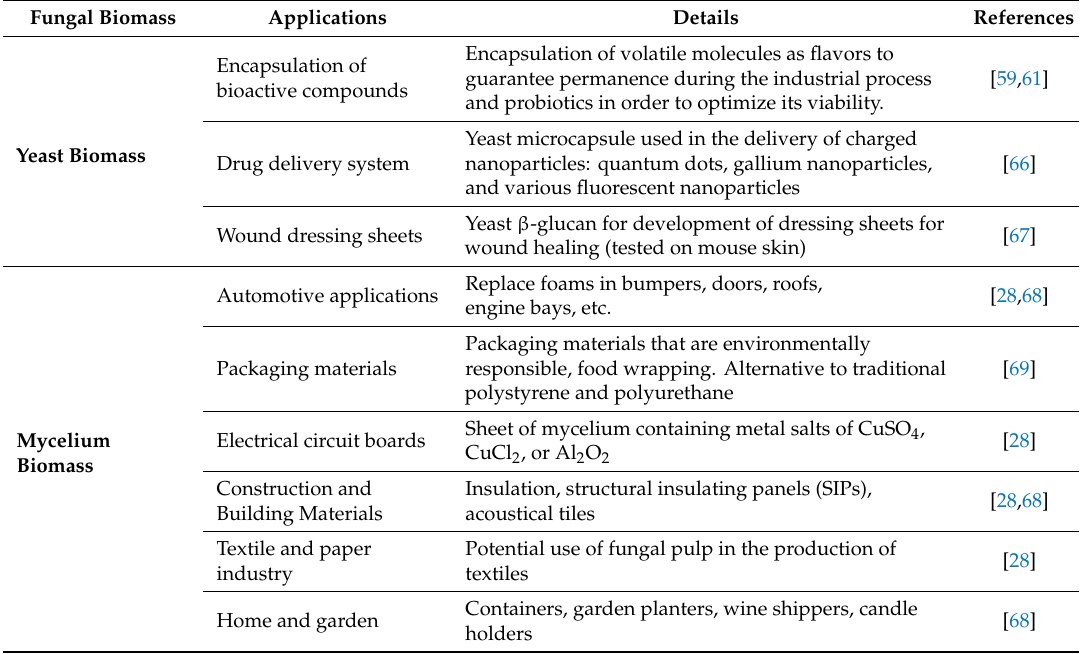
Table 1. Di ff erent applications of fungal